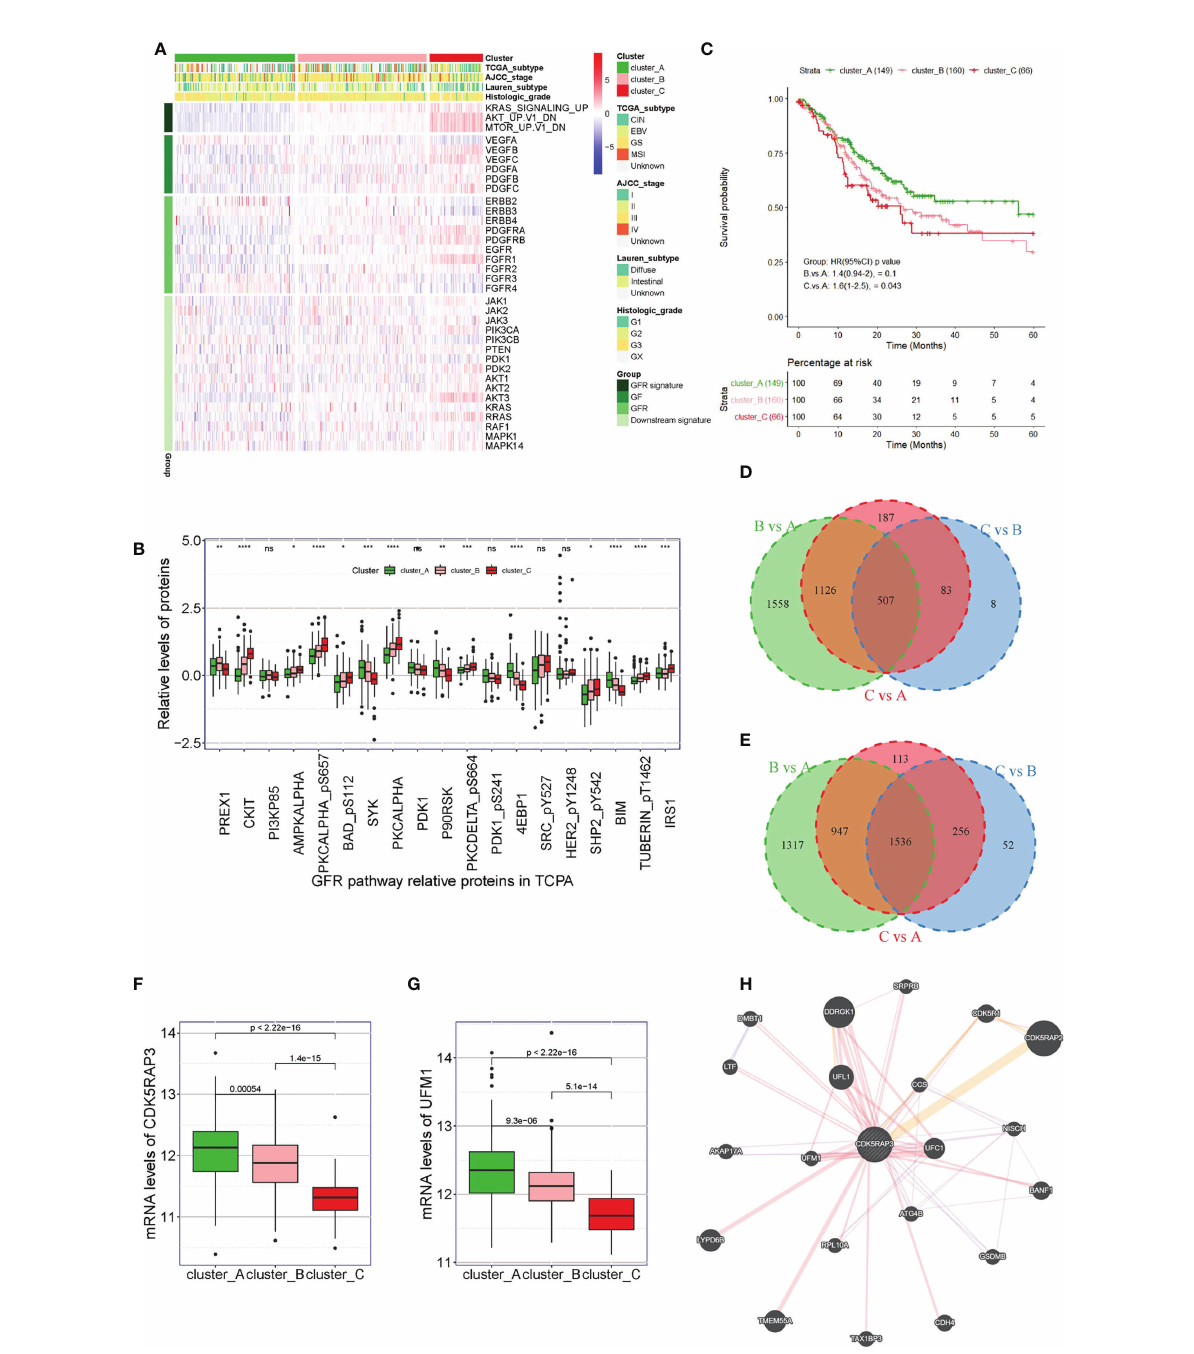
FIGURE 1 Correlation between UFM1 expression and GFR pathway and CDK5RAP3 expression. (A) Three hundred seventy- fi ve patients in the TCGA cohort were divided into three groups (Cluster A, Cluster B and Cluster C) based on unsupervised analysis and hierarchical clustering of the ssGSEA scores of the three GFR gene sets. (B) Related proteins of the GFR pathway from the TCPA database. (C) Overall survival of patients in Cluster A, Cluster B and Cluster (C, D) Venn diagram of the common downregulated genes in clusters B vs . A, C vs . A and C vs . B. (E) Venn diagram of the common upregulated genes in clusters B vs . A, C vs . A and C vs . B. (F) mRNA levels of CDK5RAP3 in the patients in Cluster A, Cluster B and Cluster C. (G) mRNA levels of UMF1 in the patients in Cluster A, Cluster B, and Cluster C. (H) Analysis diagram of the protein interaction network (GeneMANIA). *p < 0.05; **p < 0.01; ***p < 0.001; ****p < 0.0001; ns, no signi fi